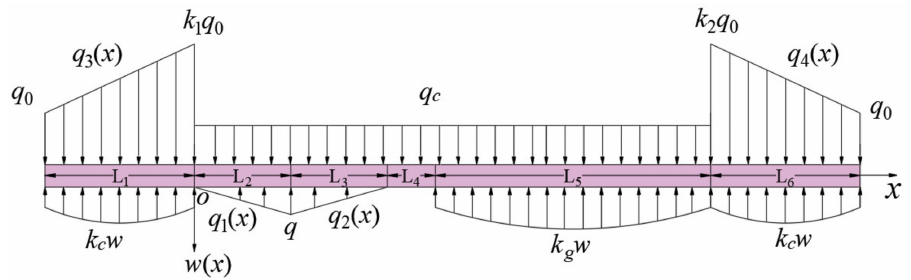
Figure 1. Mechanical model of roof